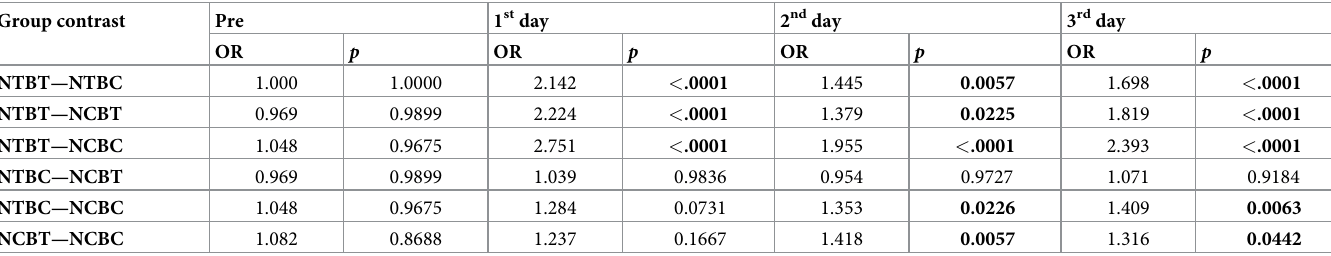
Table 3. Summaries of the post-hoc tests for pairwise comparisons of Groups on each